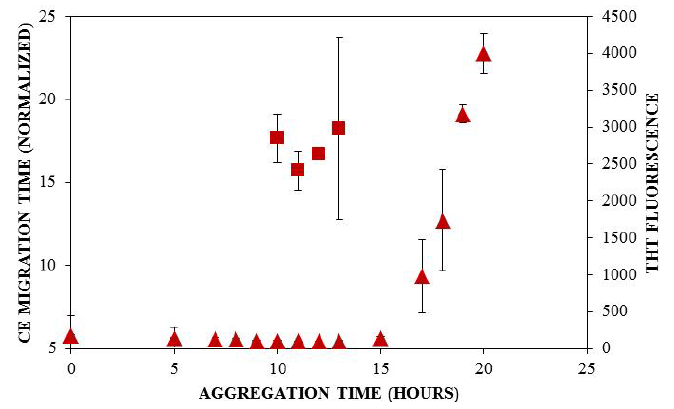
Figure 4. Comparison of lag times observed by UV-CE (  ) and ThT binding (  ). Insulin was diluted to 0.2 mg/mL in 40 mM Tris (pH 8.0) containing 150 mM NaCl.